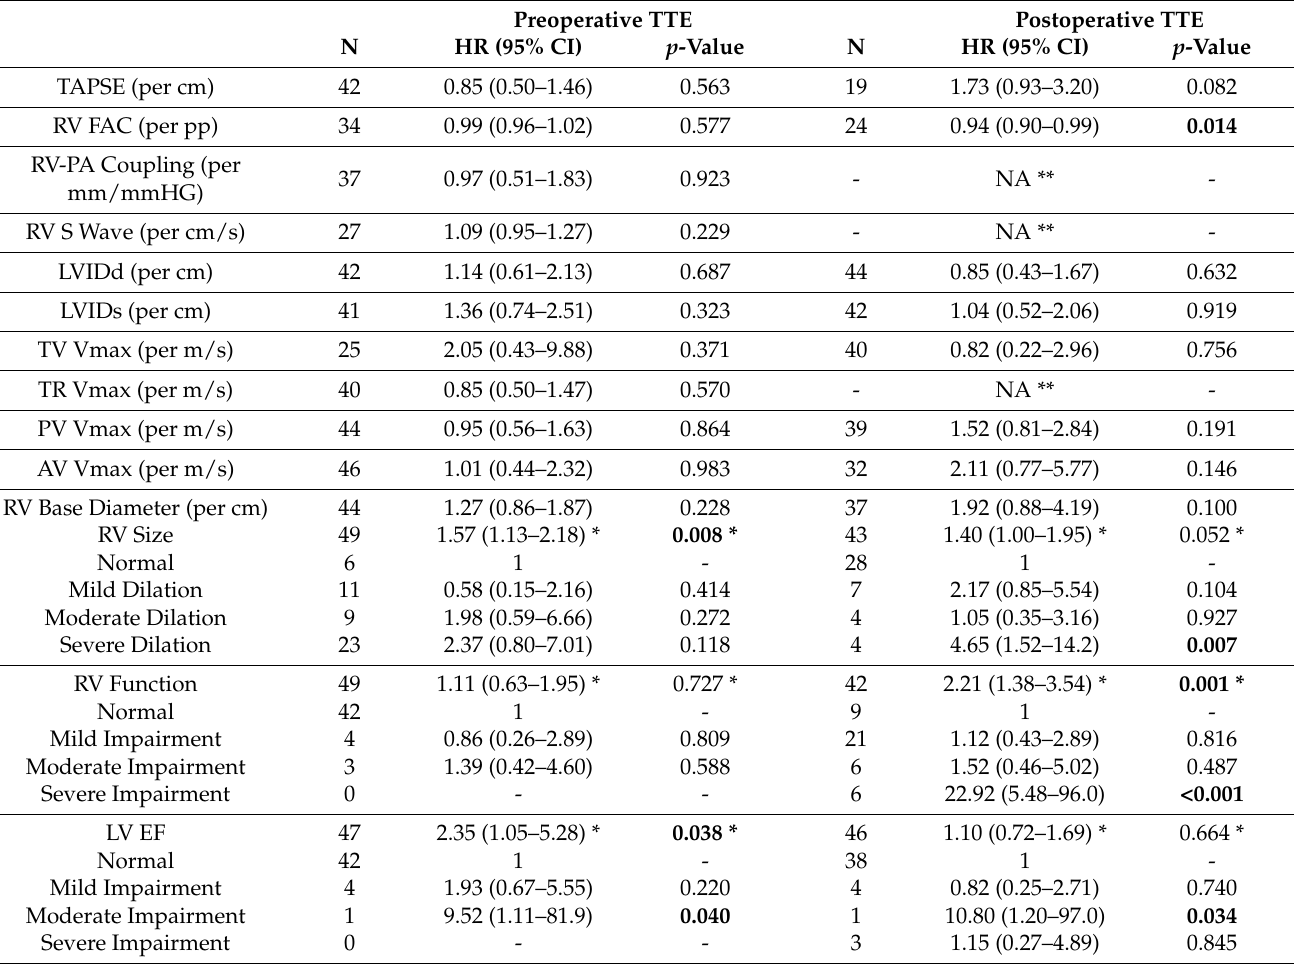
Table 3. Association Between TTE Parameters and Long-Term